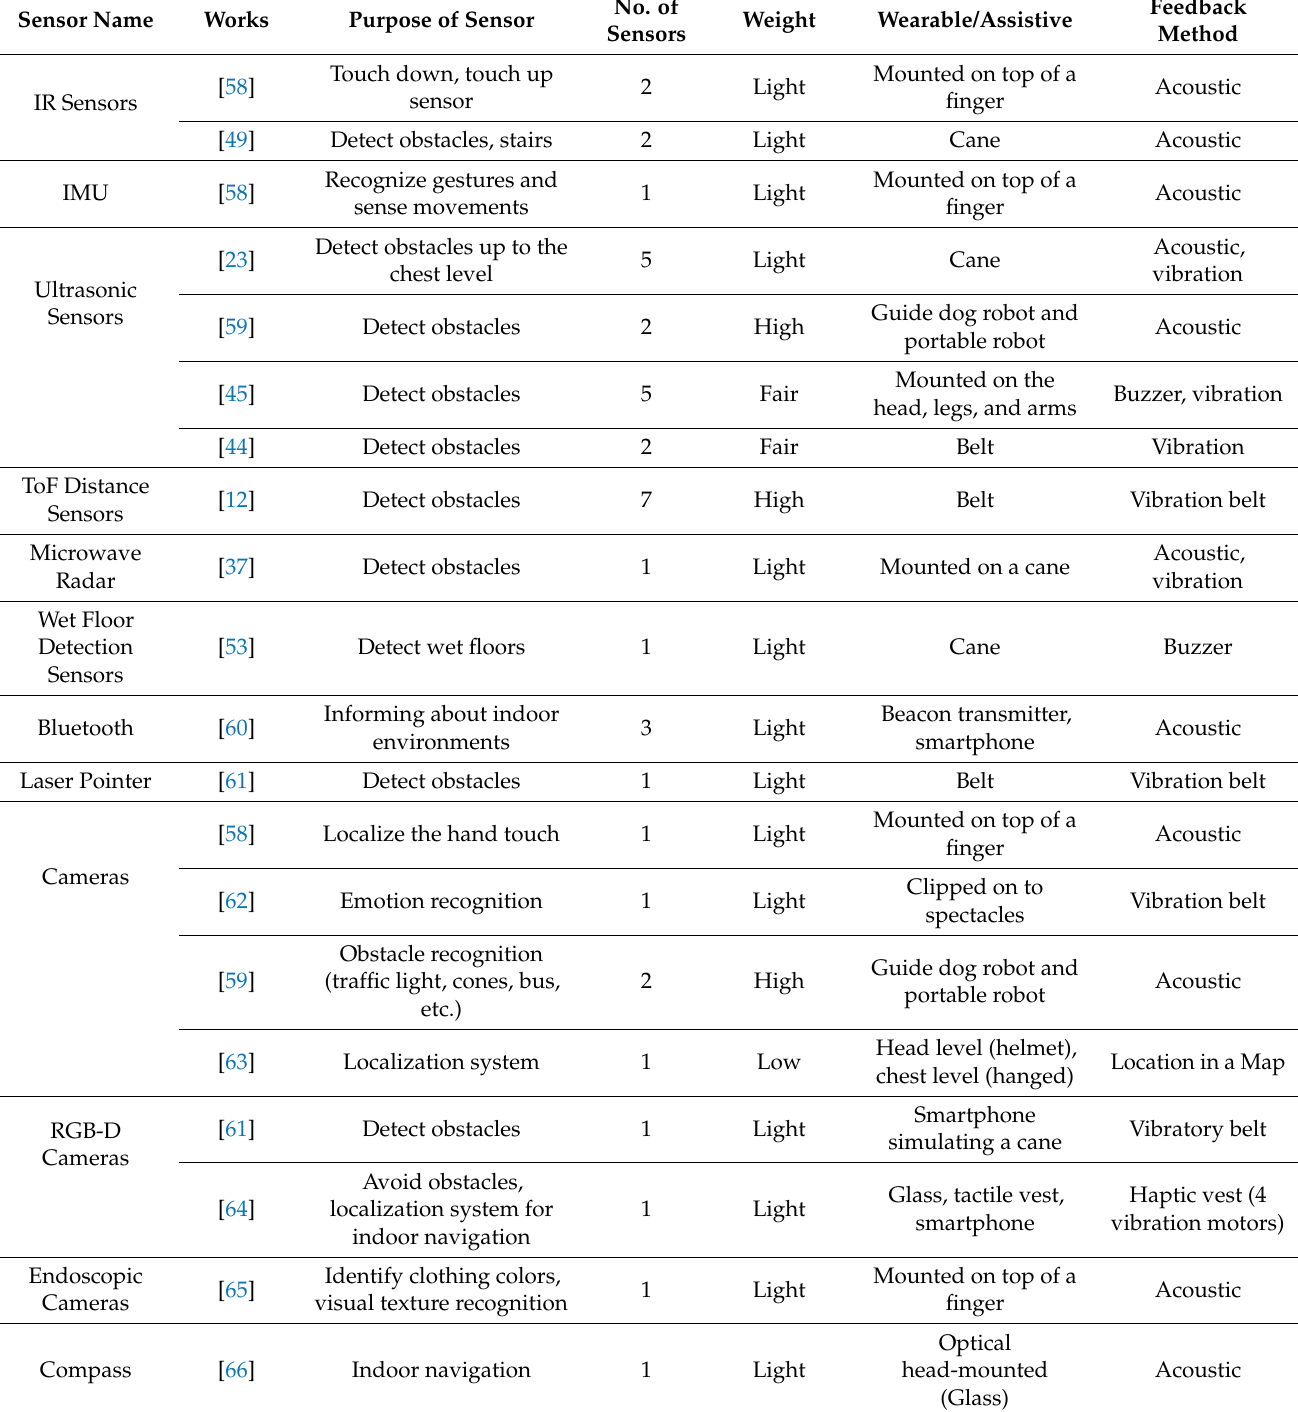
Table 1. Types of Sensors Used in Assistive Devices for